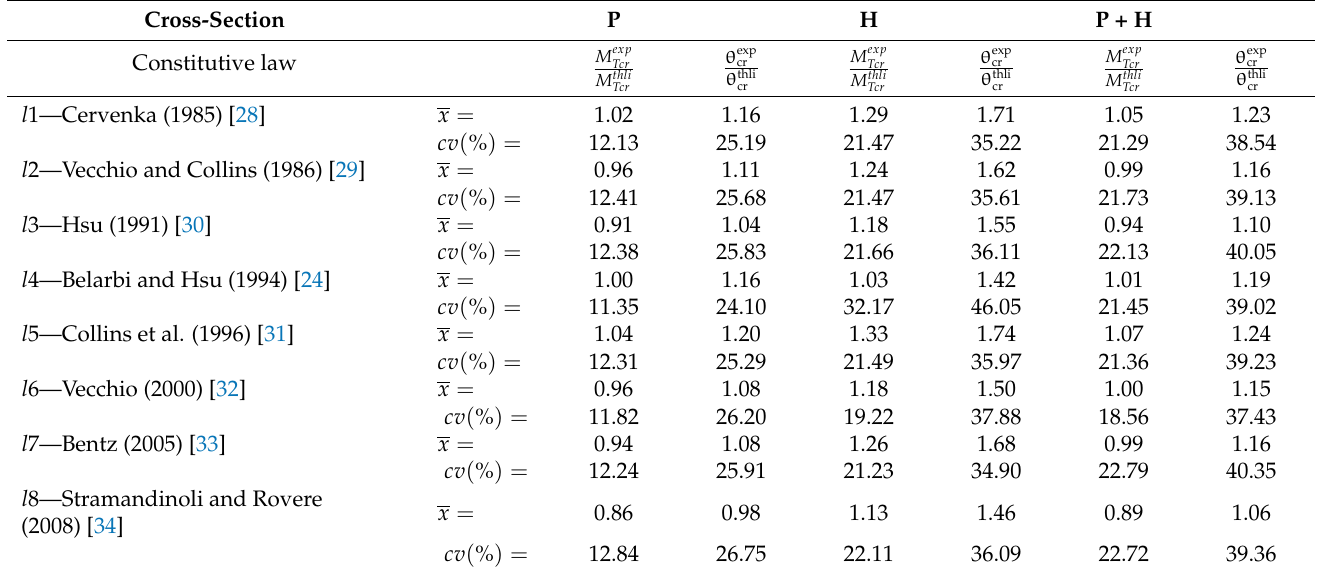
Table 1. Comparative